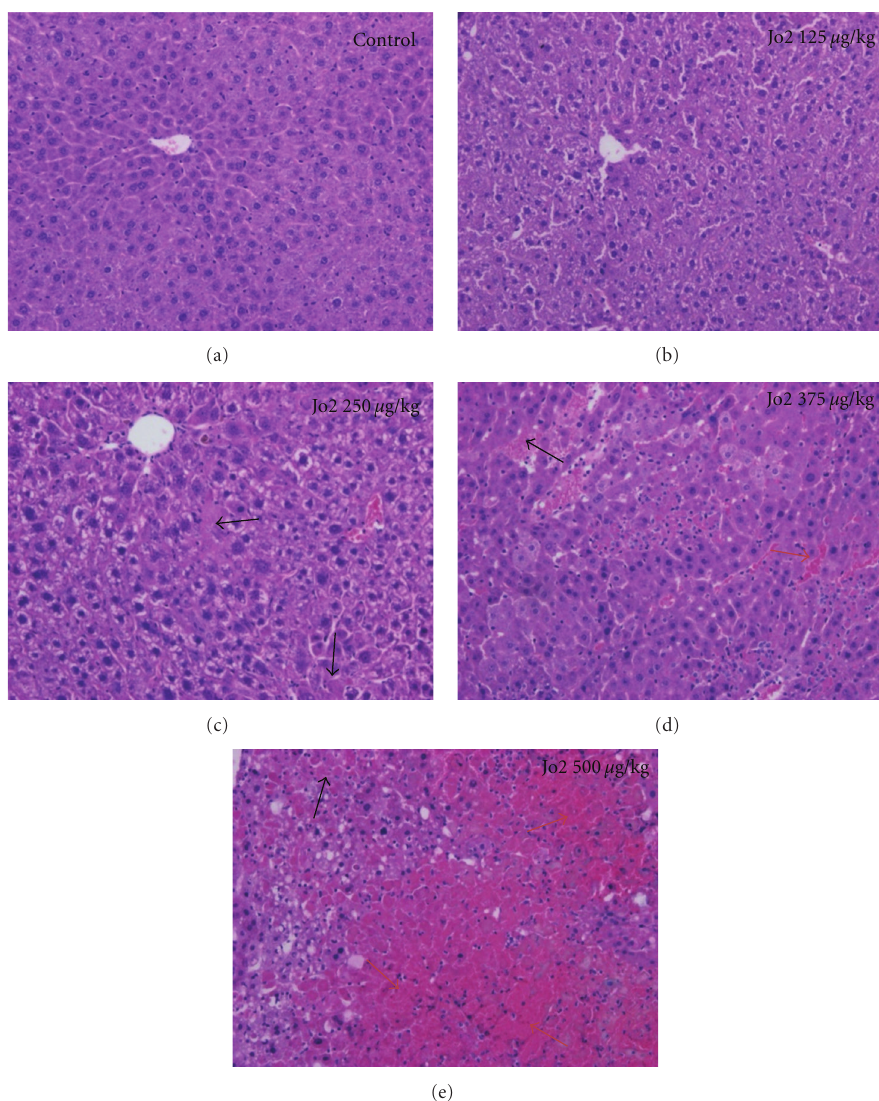
Figure 1: Nude mouse liver histology after hematoxylin and eosin staining, in mouse control (a) and after a single Jo2 injection of 125 μ g/kg (b), 250 μ g/kg (c), 375 μ g/kg (d), and 500 μ g/kg (e). Photomicrographs were taken using Olympus DP70 microscope with an original magnification of 100x. Black and blue arrows indicate apoptotic foci and necrotic foci,